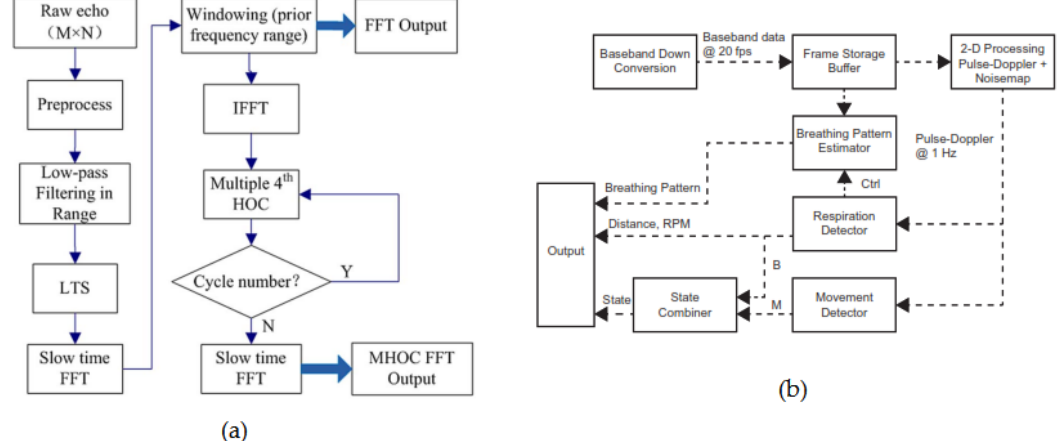
Figure 17. Vital signs retrieval algorithm for the ultra-wideband (UWB) radar in ( a ) [140] and ( b ) [131].